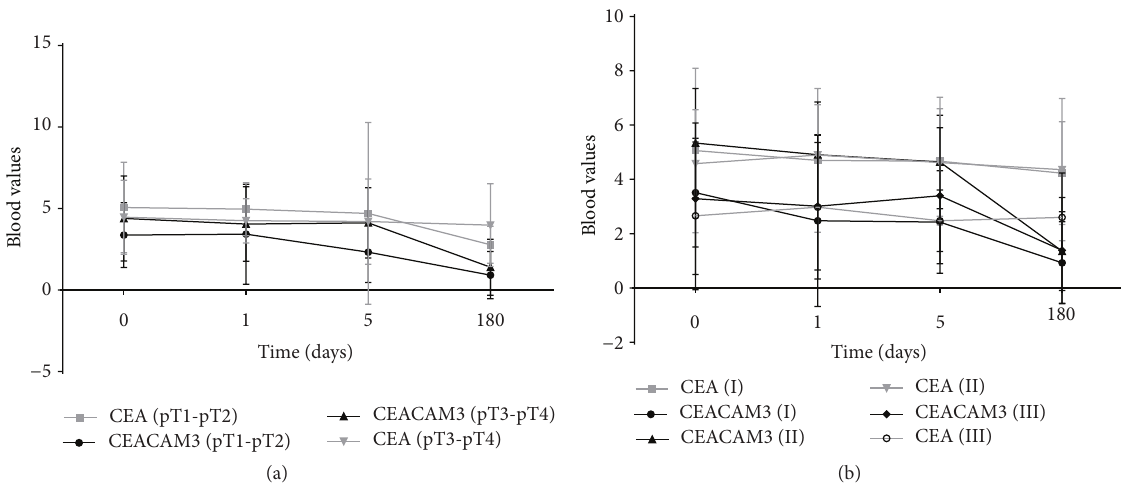
Figure 4: Comparison of CEACAM3 and CEA blood values in the CRC patients grouped by pT staging (a) or pathological stage